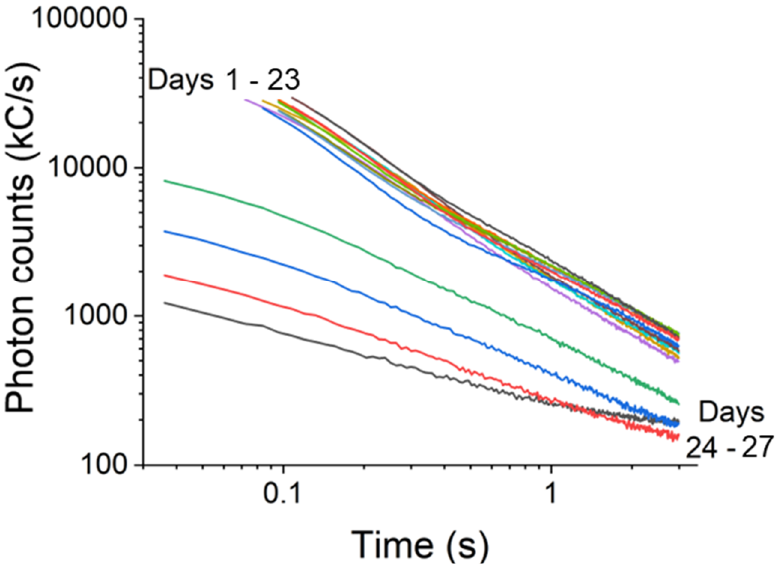
Figure 9. Biosensing chronic drought with York DF Photon Counting DF Device in Schefflera arbicola plant.